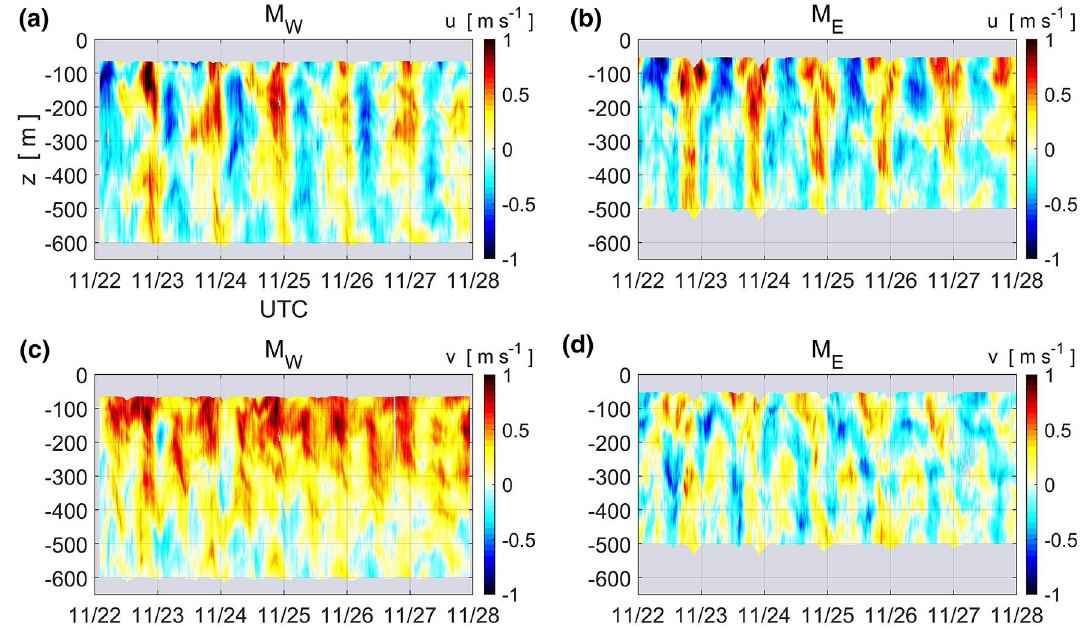
Figure 4. Temporal variations in the vertical structure of current velocity obtained by moored ADCP at M W ( a , c ) and M E ( b , d ). Zonal and meridional velocities are shown in the upper ( a , b ) and lower ( c , d ) panels, respectively.